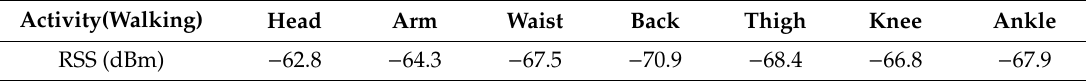
Figure 3. RSS distribution for all seven tag locations on the patient body for walking position. Table 2. Received signal strength (RSS) values for the Walking Ref